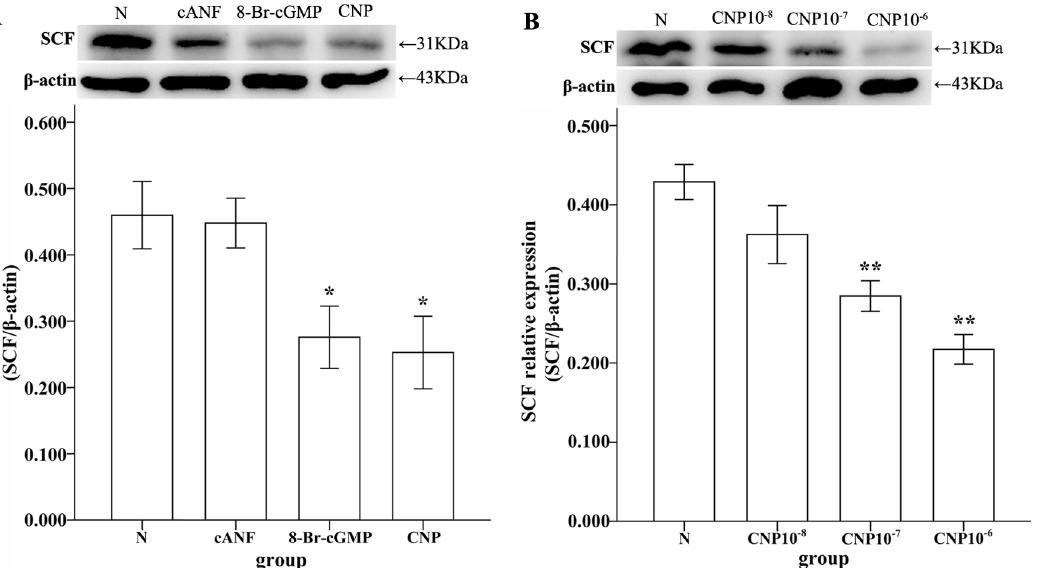
Fig 5. Western blotting analyses of SCF expression in cultured GSMCs with different pretreatment conditions. (A) The ratio of SCF/ β -actin was 0.460 ± 0.051 in N, 0.448 ± 0.038 in cANF(10 − 6 mol/L) group, 0.276 ± 0.047 in 8-Br-cGMP (10 − 6 mol/L) group and 0.253 ± 0.055 CNP (10 − 6 mol/L) group. The expression levels were significantly different in the 8-Br-cGMP (10 − 6 mol/L) group and CNP (10 − 6 mol/L) group ( * P < 0.05, one-way ANOVA), but not in the cANF(10 − 6 mol/L) group (P > 0.05, one-way ANOVA) compared with N. (B) The ratio of SCF/ β -actin was 0.429 ± 0.022 in N, 0.362 ± 0.037 in CNP (10 − 8 mol/L) group, 0.282 ± 0.020 in CNP (10 − 7 mol/L) group, and 0.217 ± 0.019 CNP (10 − 6 mol/L) group. These results showed that high concentrations of CNP (10 − 7 mol/L and 10 − 6 mol/L) could significantly decrease the expression of SCF ( ** P < 0.01, one-way ANOVA).